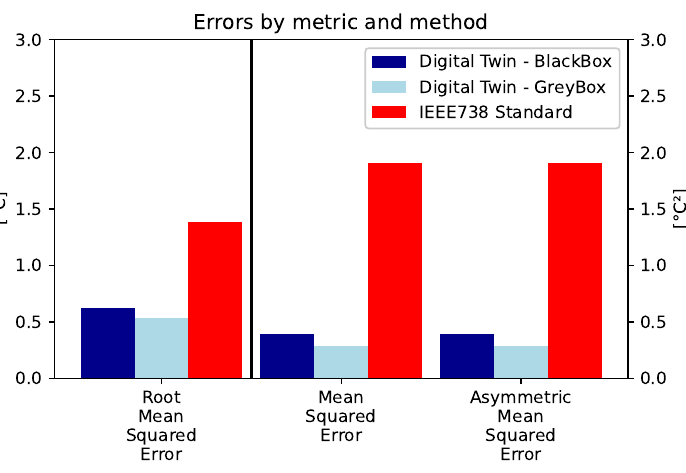
Figure 4. Performance metrics: the plot represents the mean values of the metrics presented in Section 3.3. The grey-box approach achieves optimal performances, especially in terms of AMSE, appearing to be the optimal approach.